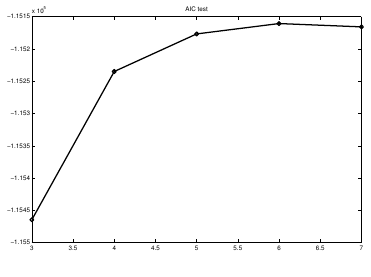
Figure 4. Test for the appropriate regularisation with Akaike’s Information Criterion